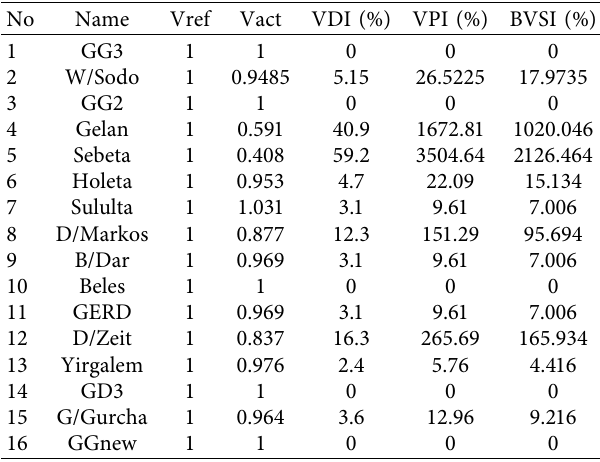
Table 6: BVSI during an outage of Sebeta to the Holeta branch without